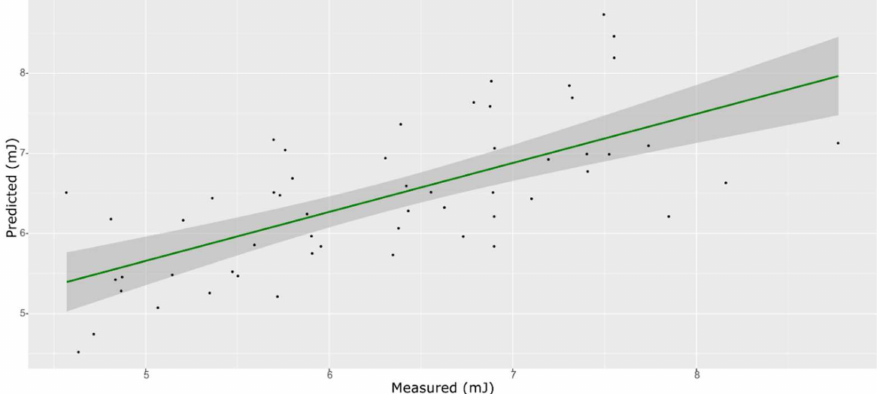
Figure 14. PLS model for BCh on the test set, using the full spectral range.